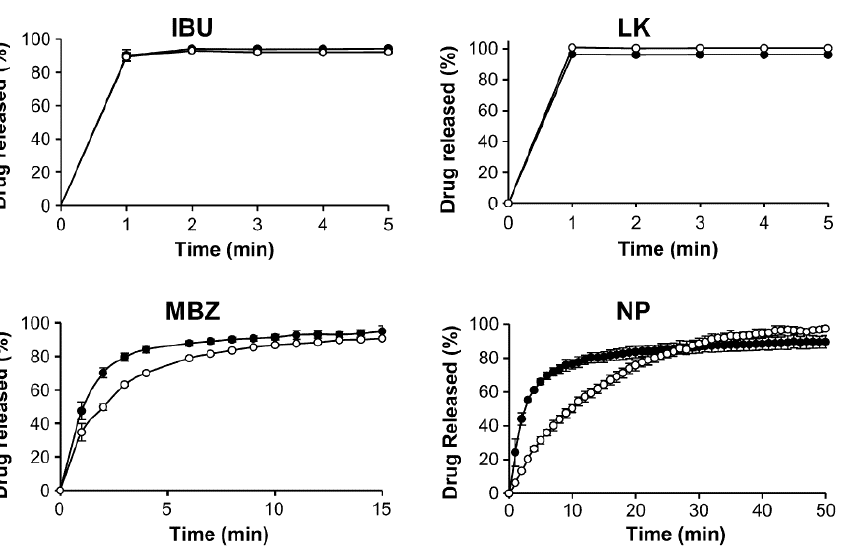
Figure 5. Drug release from drug loaded FCC (full circle) in comparison with FCC/drug physical mixture (empty circle). IBU = ibuprofen, LK = potassium salt of losartan, MBZ = metronidazole, NP = nifedipine. Reprinted with permission from Ref. [39] 2014, Elsevier.